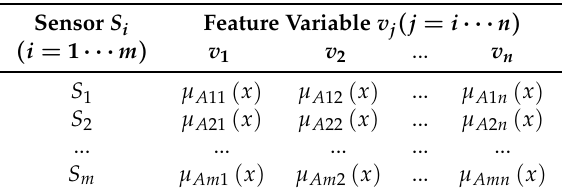
Table 1. The obtained m × n groups feature